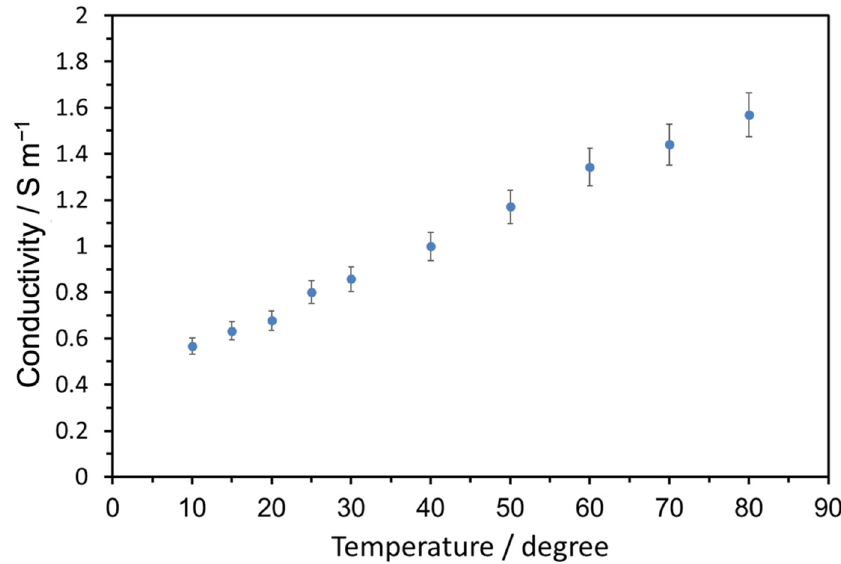
Figure 2. Variation in the conductivity of a 1 mol dm − 3 NaClO 4 in 1:1 EC/DEC electrolyte with temperature.